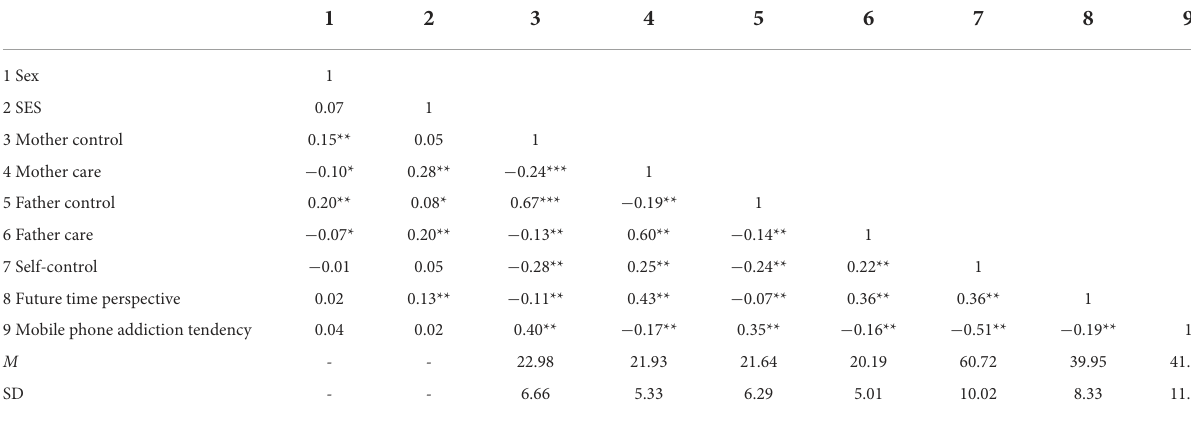
TABLE 2 Descriptive statistics and correlations among variables.